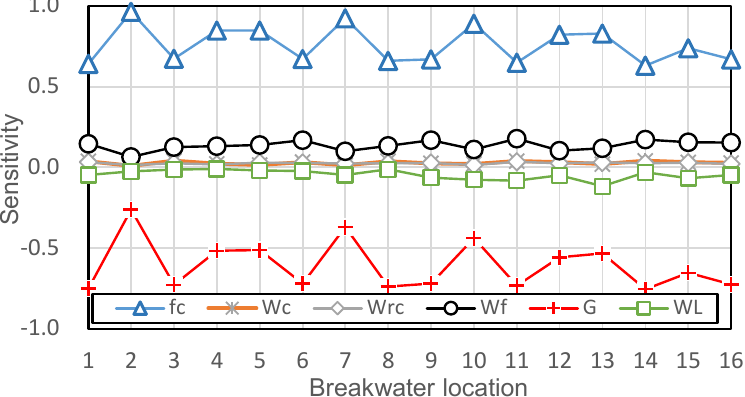
Figure 4. Reliability indices of breakwater (sliding).